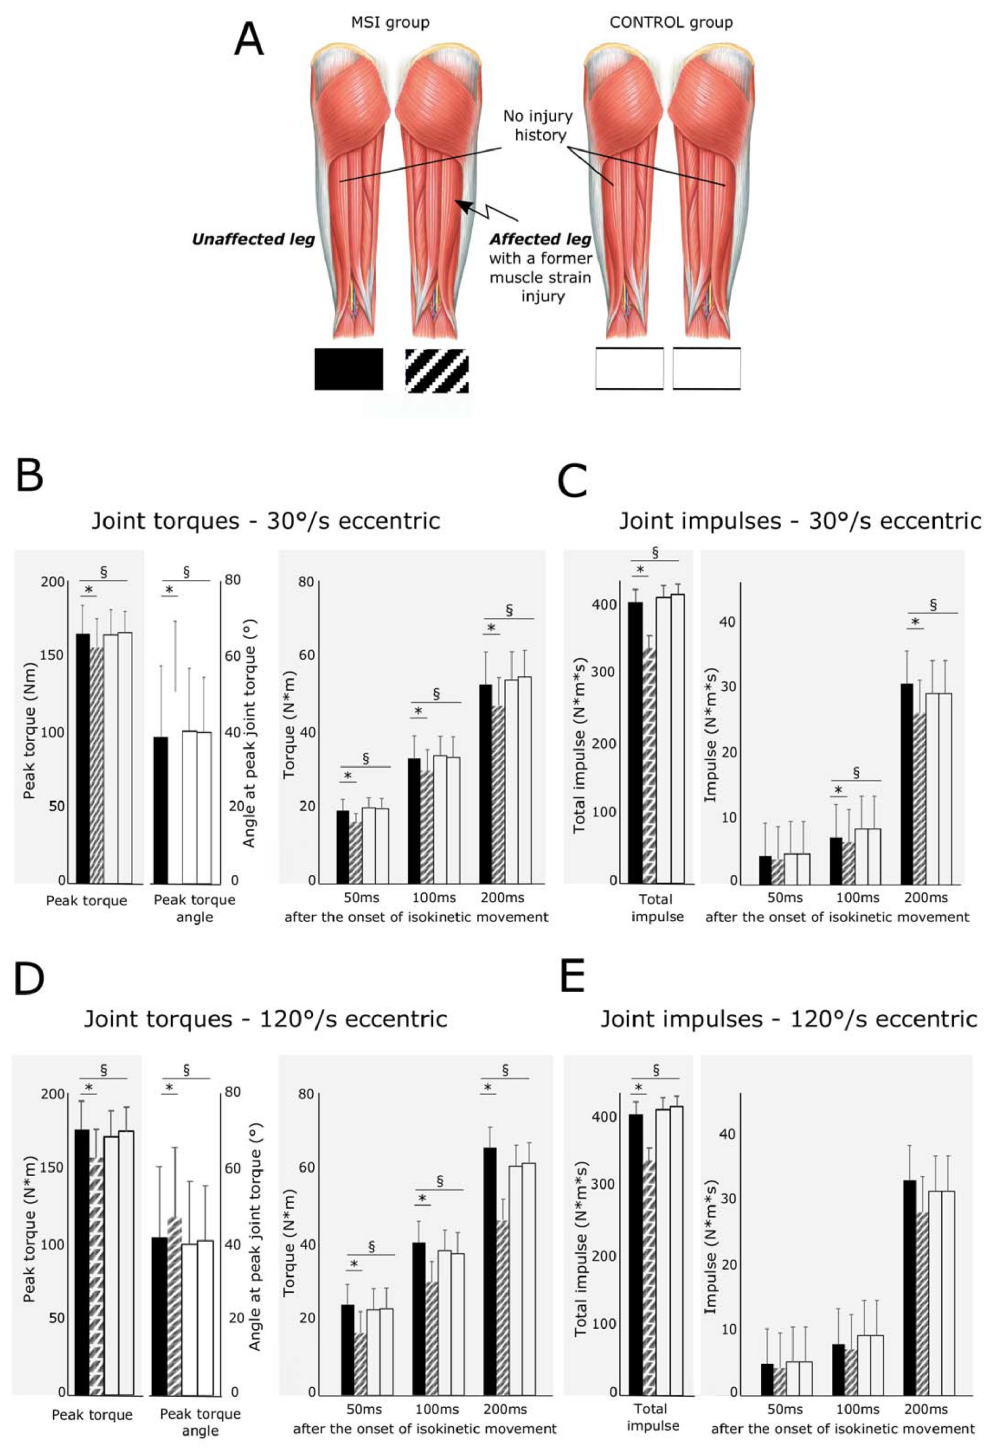
Fig 3. A illustrates the MSI group with previous unilateral hamstring strain injuries experienced in the M. biceps long head (left) and the healthy CONTROL group with bilateral healthy legs. Graphs B–E illustrate changes in joint torques and impulses: B displays differences in the peak knee flexion joint torque (ordinate) and the corresponding knee flexion angle as well as the joint torques at 30ms, 50ms 100ms and 200ms after the movement onset of the lever arm at 30˚/s speed for both groups. Graph C displays differences in the total impulse and impulses calculated for the intervals 0–50ms, 0–100ms